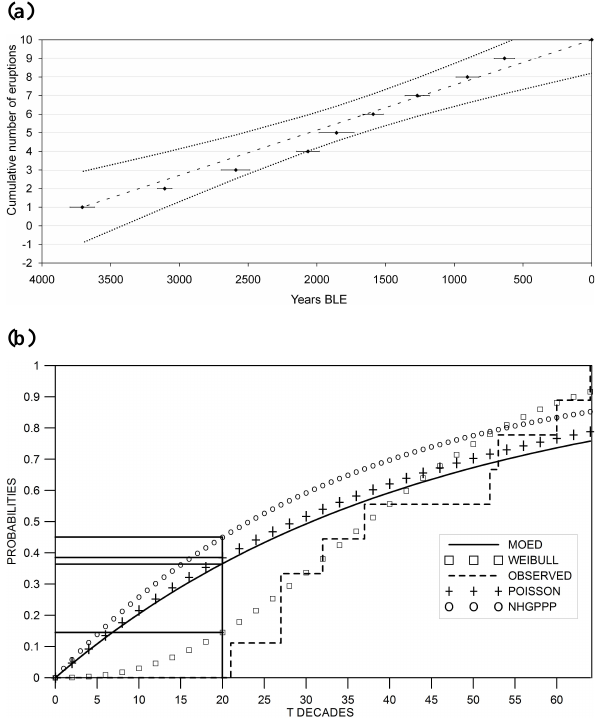
Fig. 4. (a) Cumulative number of eruptions of El Chich´on volcano for the period 3707years BLE in the magnitude class VEI ≥ 3, as- suming that the eruptions 1524 and 1657years BLE are a single event occurred near 1591. The slopes of the dashed line repre- sent the eruption rate of the whole series. ( λ global =0.0243 erup- tions per decade). (b) Probabilities calculated by NHGPPP, Poisson and Weibull distributions of at least one eruption, with VEI ≥ 3 in a given time interval from “El Chich´on 2C” over 3707years BLE. The horizontal and vertical lines show the different probabilities of at least one eruption in 20decades with VEI ≥ 3 (NHGPPP: 0.4499, MOED: 0.3657, the Weibull distribution: 0.1452 and Poisson dis- tribution: 0.3847).